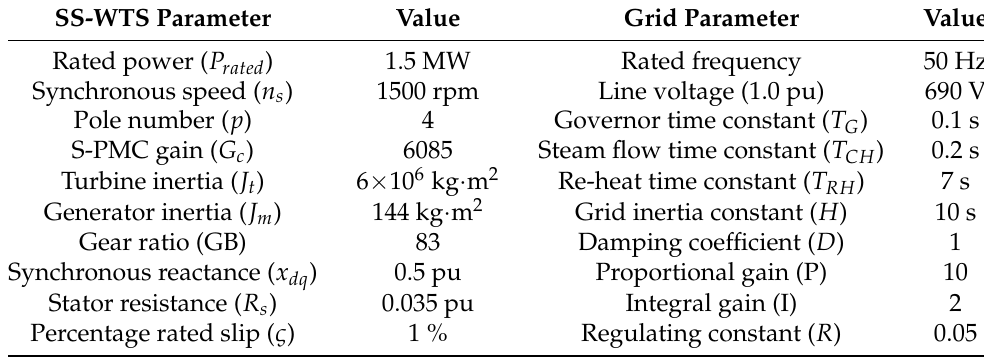
Table 1. SS-WTS and grid simulation